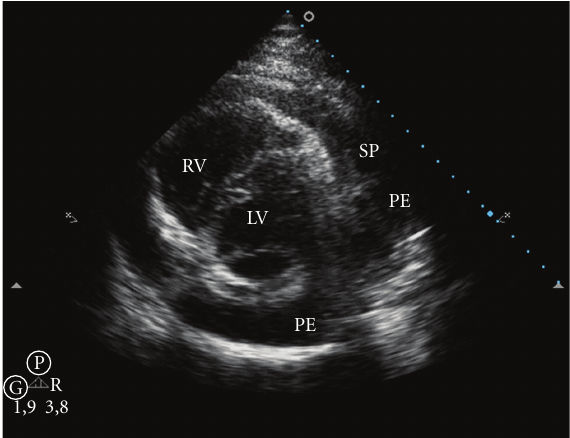
MRA CS Figure 3: Right atriotomy showing the coronary sinus vegetation (RA: right atrium; CS: coronary sinus; M: